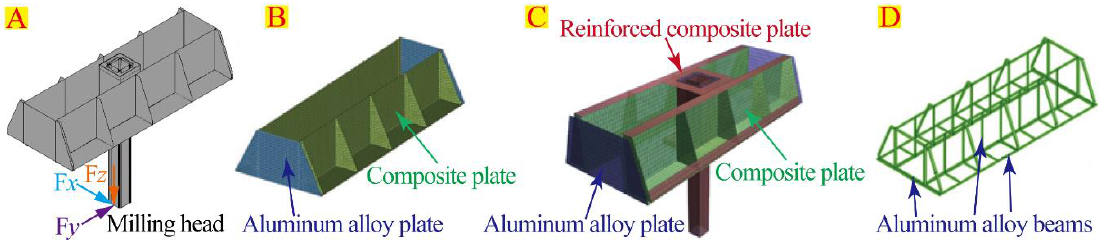
Figure 4. Models of the framework: ( A ) Three-dimensional model; ( B ) finite element model of portal before optimization; ( C ) finite element model after optimization; ( D ) support model.